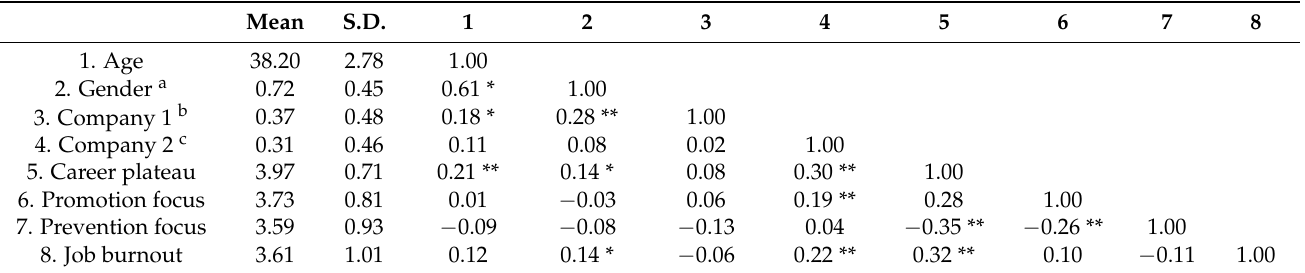
Table 3. Descriptive statistics and correlation